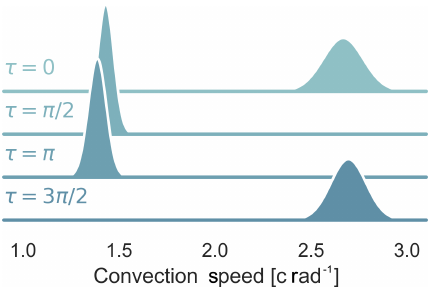
Figure 10. Probability distributions of the convection speed of dynamic stall with airfoil blowing different phases of harmonic U amp = 0 . 5, k = 0 . 08, Re = 2 . 5 × 10 5 and α inflow ( τ ). U α amp = 10 ◦ .